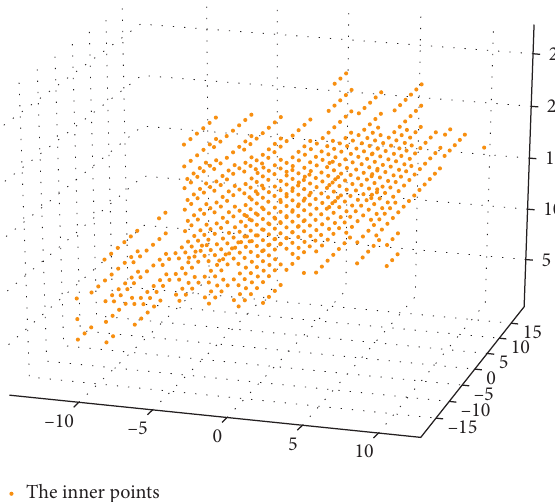
Figure 12: Schematic diagram of internal data points of